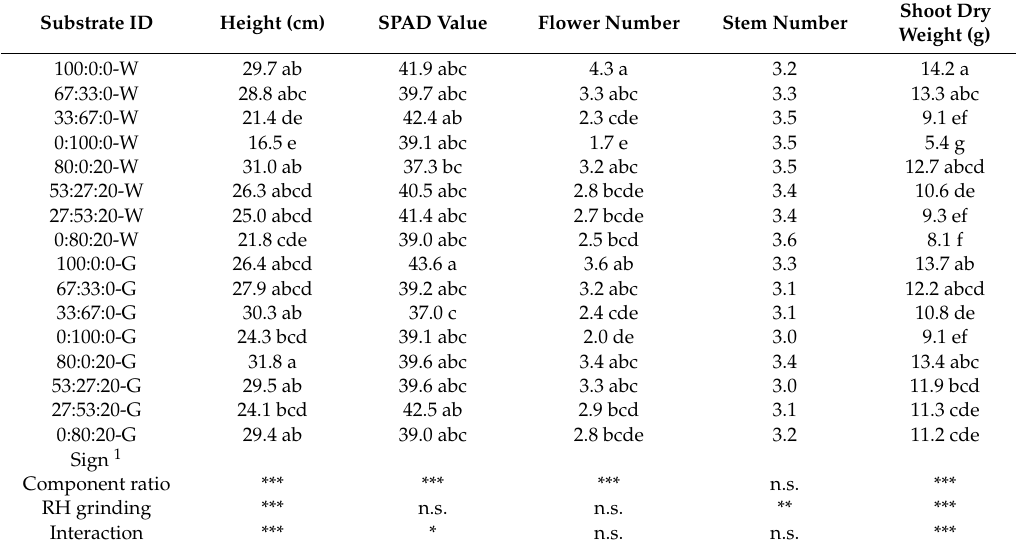
Table 5. Interaction e ff ect of component ratio and rice hulls (RH) grinding on rose plant traits. Substrate